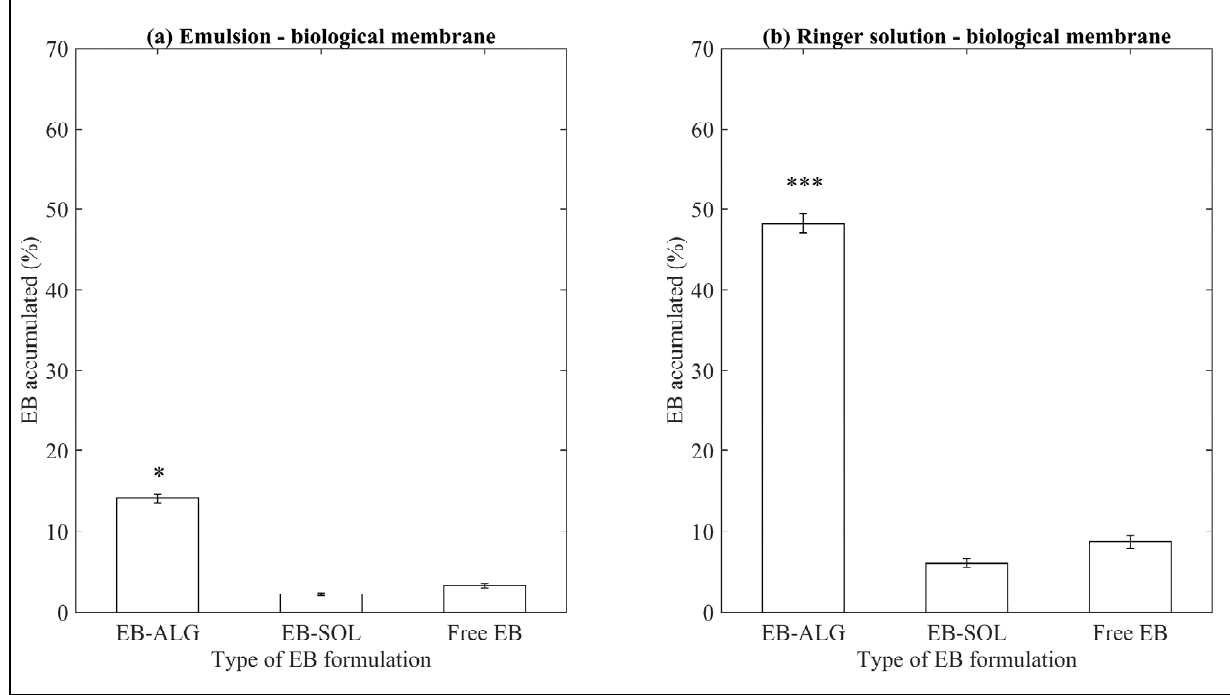
Figure 3. Accumulated dissolution/permeation (%) of EB determined using ex vivo biological membranes. ( a ) Represents EB accumulated in emulsion (EM) as the donor media with biological membrane, and ( b ) represents EB accumulated in Ringer solution (RS) as donor media with biological membrane. Values represent the mean with standard deviation, n = 5, with an initial concentration of microparticles of 0.53 mg/mL for emulsion, and 0.56 mg/mL for Ringer solution. p < 0.05 (*) and p < 0.001 (***) were taken to be statistically different compared to free EB (control), calculated by a t-student test.